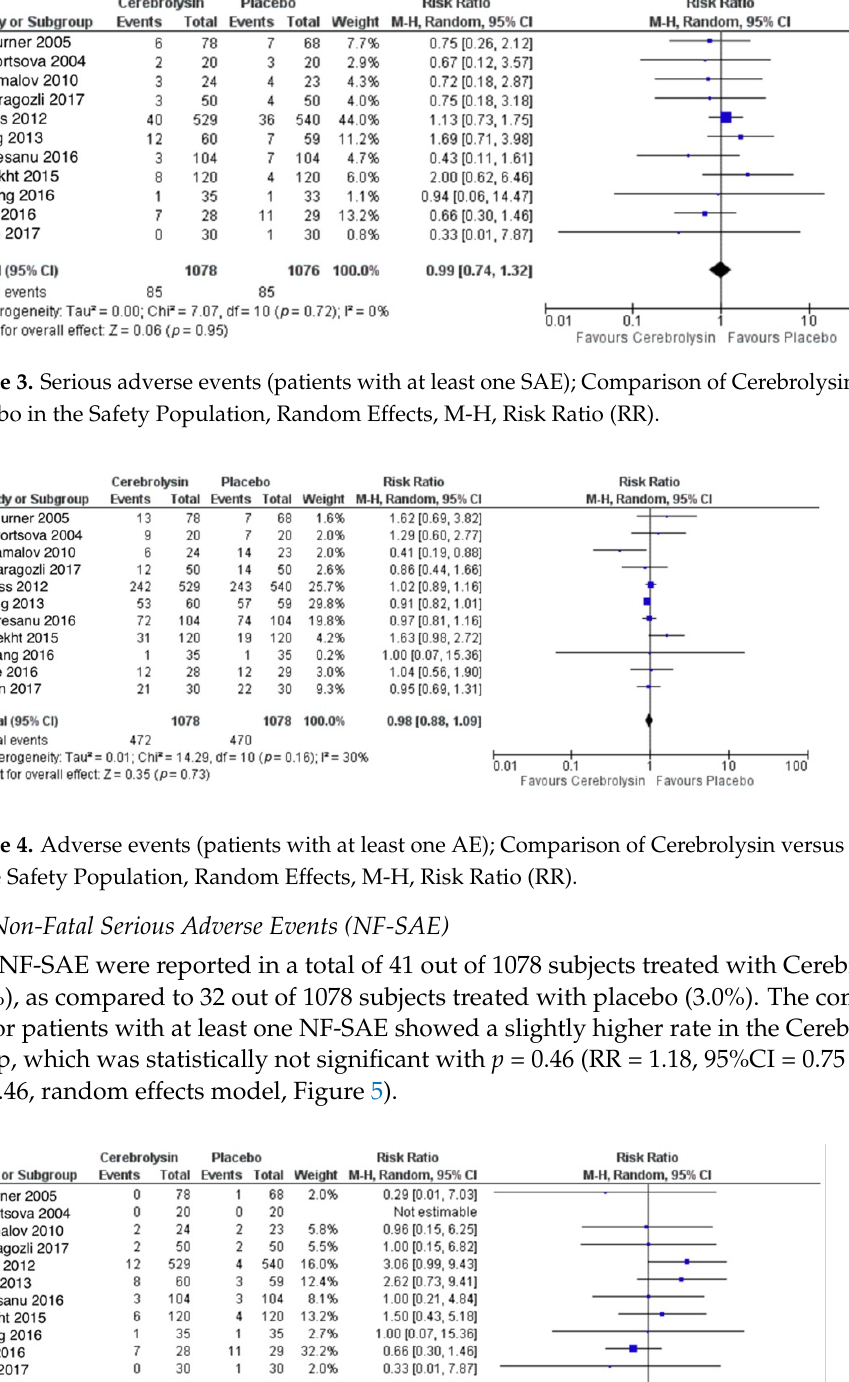
Figure 5. Non-fatal serious adverse events (patients with at least one NF-SAE); Comparison of Cerebrolysin versus Placebo in the Safety Population, Random Effects, M-H, Risk Ratio (RR).